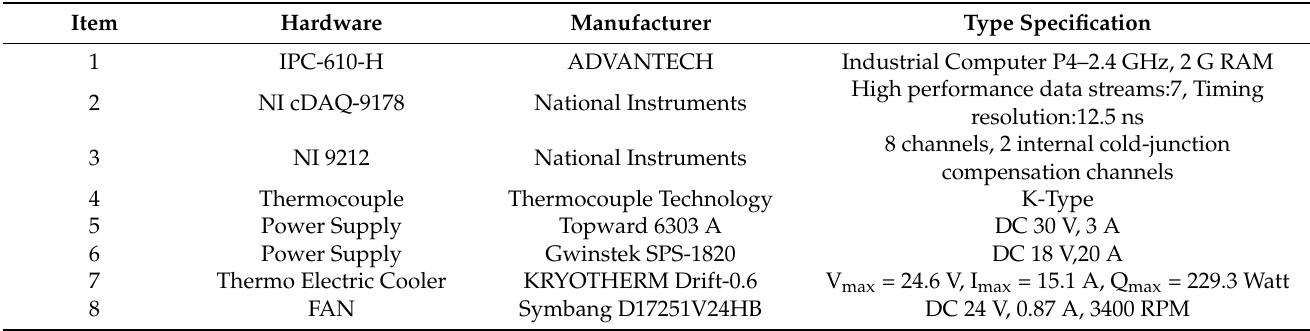
Table 3. Specifications of the